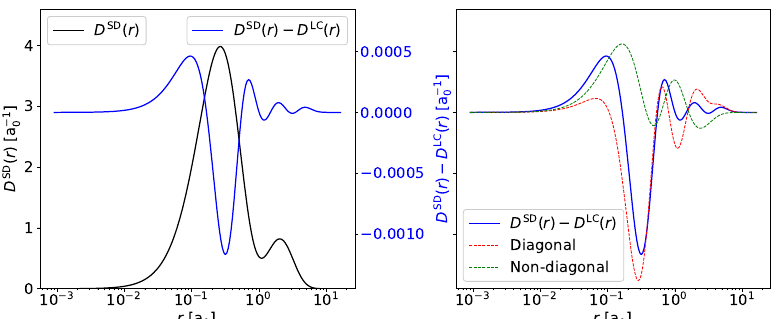
Figure 1. Left panel/in black: radial electron density D SD ( r ) for the ground state of beryllium using the MR ( 1 s 2 2 s 2 + 1 s 2 2 p 2 ) − SD ( n = 3 ) correlation model. In blue, difference between the radial electron densities calculated using, respectively, this correlation model ( D SD ( r ) ) and correlation limited to the Layzer complex ( D LC ( r ) ). Right panel: analysis of diagonal (in red) and off-diagonal contributions (in green) to the total D SD ( r ) − D LC ( r ) difference (in blue). See text for